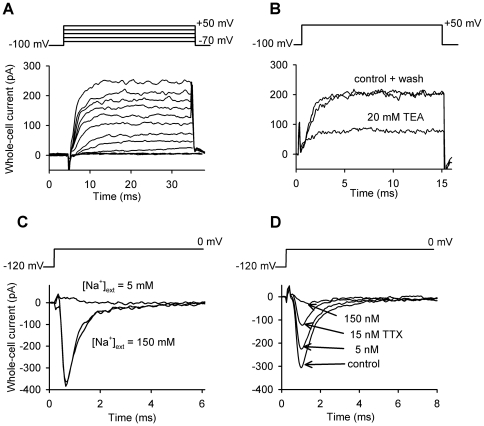
Electrophysiological properties of voltage-gated ion channels in chondrocytes.(A) Whole-cell K+ currents recorded from a patch-clamped chondrocyte one day after cell isolation. Depolarizing pulses ranging from −70 to +50 mV were applied every 15 seconds from a holding potential of −100 mV. Currents show voltage-dependent gating. (B) Application of 20 mM extracellular TEA reversibly blocked the K+ current. The cell was held at a holding potential of −100 mV and was depolarized to +50 mV every 15 s. (C) Whole-cell Na+ currents recorded from a patch-clamped chondrocyte two days after cell isolation. The cell was held at a holding potential of −120 mV and was depolarized to 0 mV every 15 s. The Na+ current disappeared in an external solution containing 5 mM Na+, identical to the Na+ concentration in the pipette. (D) Tetrodotoxin reversibly blocked the Na+ current in a dose dependent manner.